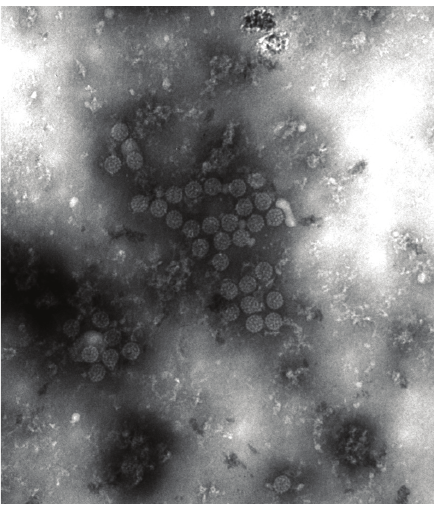
Figure 1: Viral inclusions seen on electron microscopy of urine epithelial